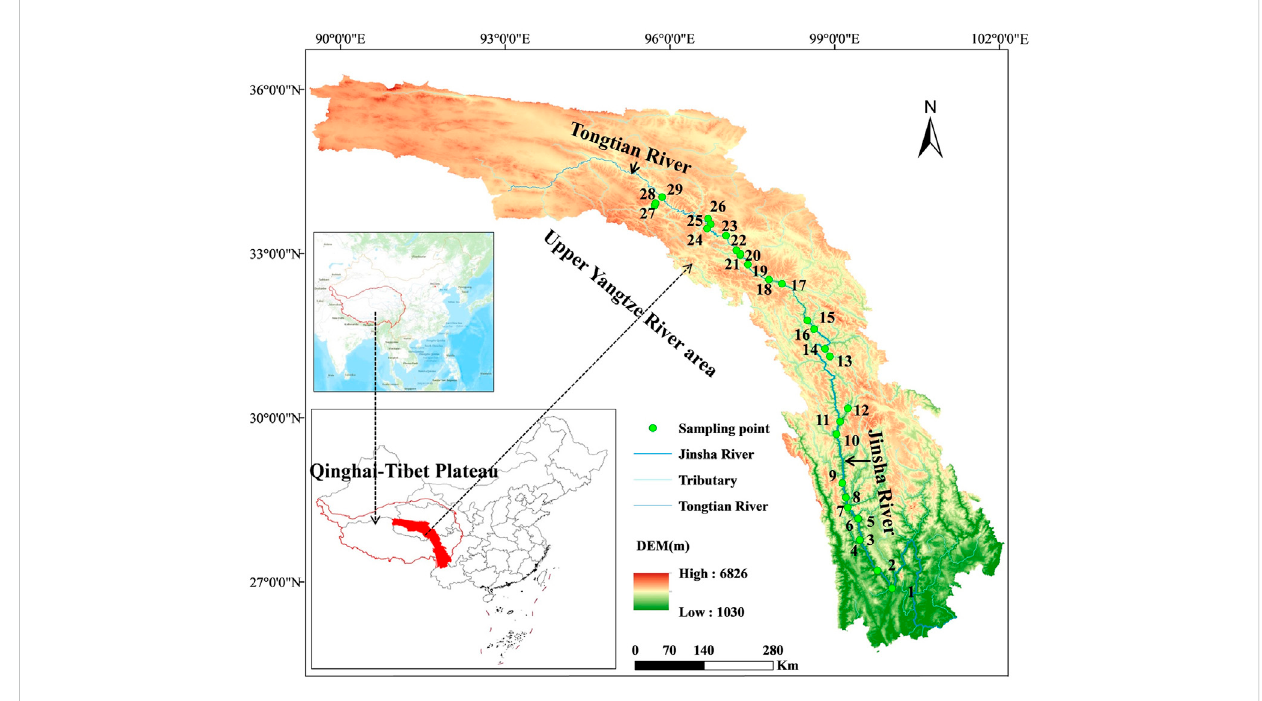
FIGURE 1 Distribution of sampling points in the study